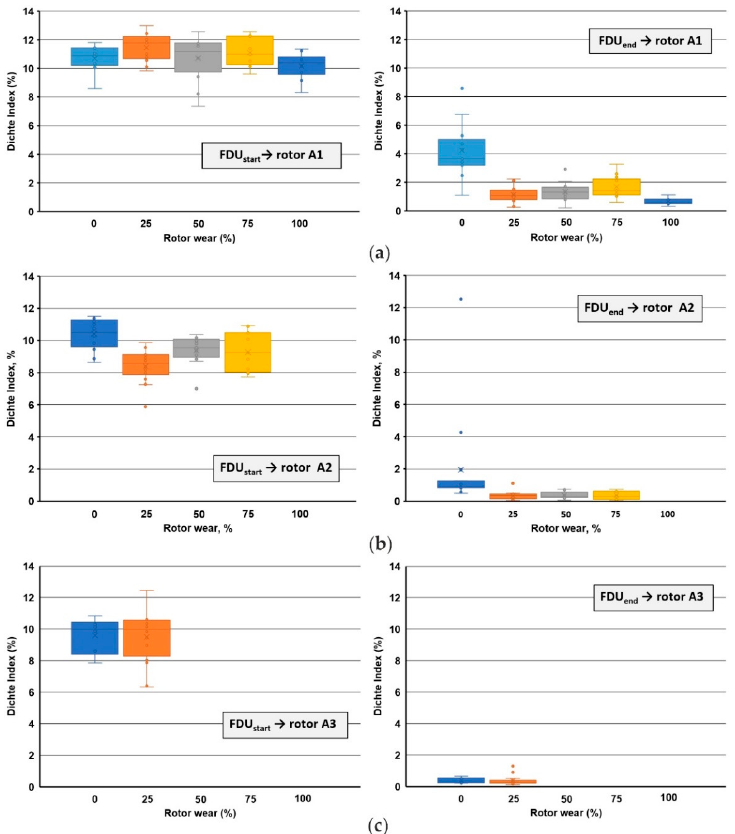
Figure 3. Comparison of Dichte Index values within rotors wear: ( a ) rotor A1 (series 1/VT to 5/VT); ( b ) rotor A2 (series 1/VT to 4/VT); ( c ) rotor A3 (series 1/VT to 2/VT). concluded that the rotor contains moisture which is gradually released. With a 100% rotor wear (series 5/VT), it can be stated that even with such a high wear, the rotor achieves the lowest DI not only within the average values but also within the individual melts. These trends for DI are also seen in the density results of vacuum-solidified samples. Figure 4 presents a summary of changes in the alloy density for the beginning and end of refining for the three tested rotors A1, A2 and A3.